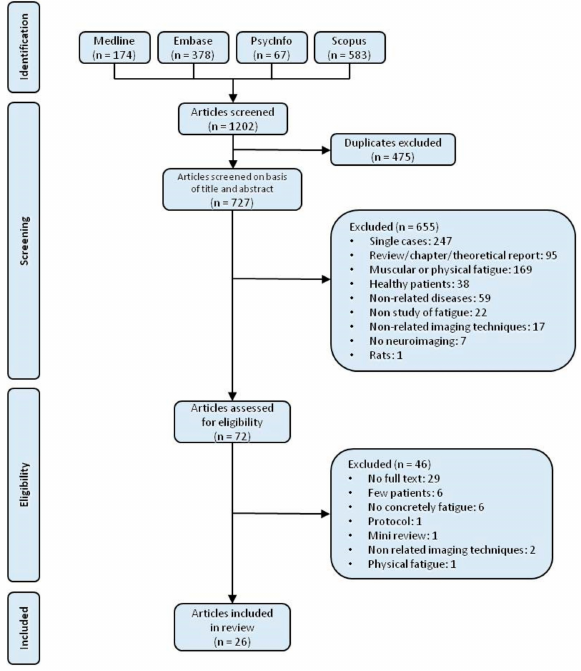
Figure 1. Flowchart of the review